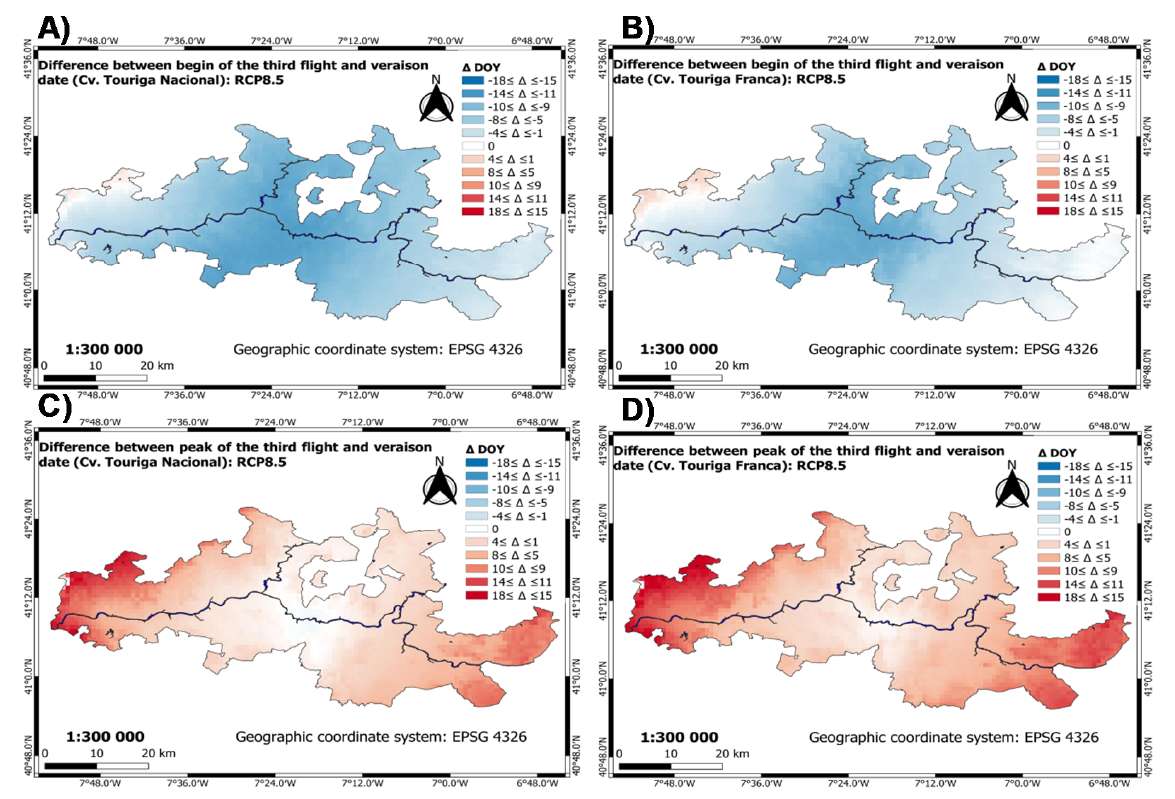
Figure 7. Phenology maps for the future period (2051–2080, RCP8.5) covering the entire Douro Demarcated Region. The color scale shows the difference between Lobesia botrana flight and grapevine (Δ DOY), namely third flight with veraison. In addition, the varieties under study are represented, cv. Touriga Nacional left; ( A , C ) and Touriga Franca right; ( B , D ). Lastly, the Douro river and main tributaries are also outlined (thick blue line).